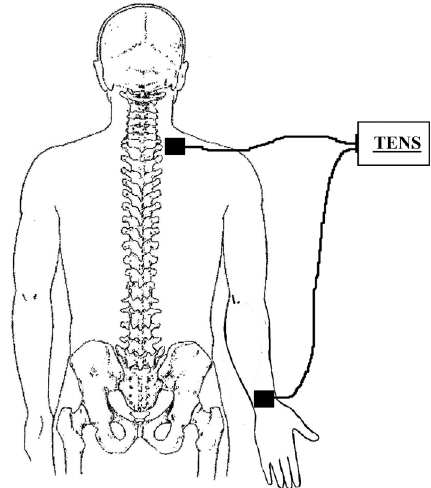
Figure 2. Location of